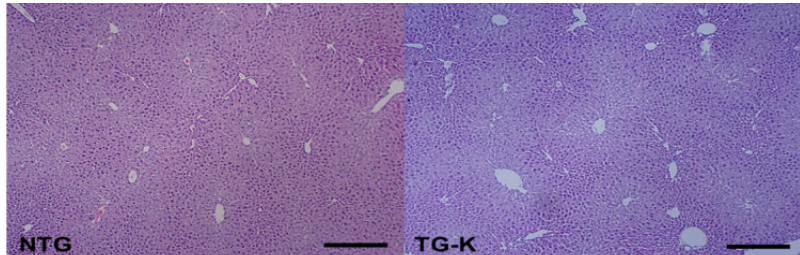
Figure 1. Representative microphotograph of livers stained with hematoxylin and eosin (H&E) of NTG, TG-K, TG-116 and TG-99. Moderate centrilobular necrosis was observed in the liver of NTG, TG-K and TG-116. Severe centrilobular necrosis was observed in the TG-99. Arrows indicate centrilobular necrosis. NTG is wild type mice; TG-K is transgenic mice which have wild type core; TG-116 is transgenic mice whose serine116 was replaced by isoleucine; TG-99 is transgenic mice in which serine 99 was substituted with glutamine. Scale bar = 200 μ